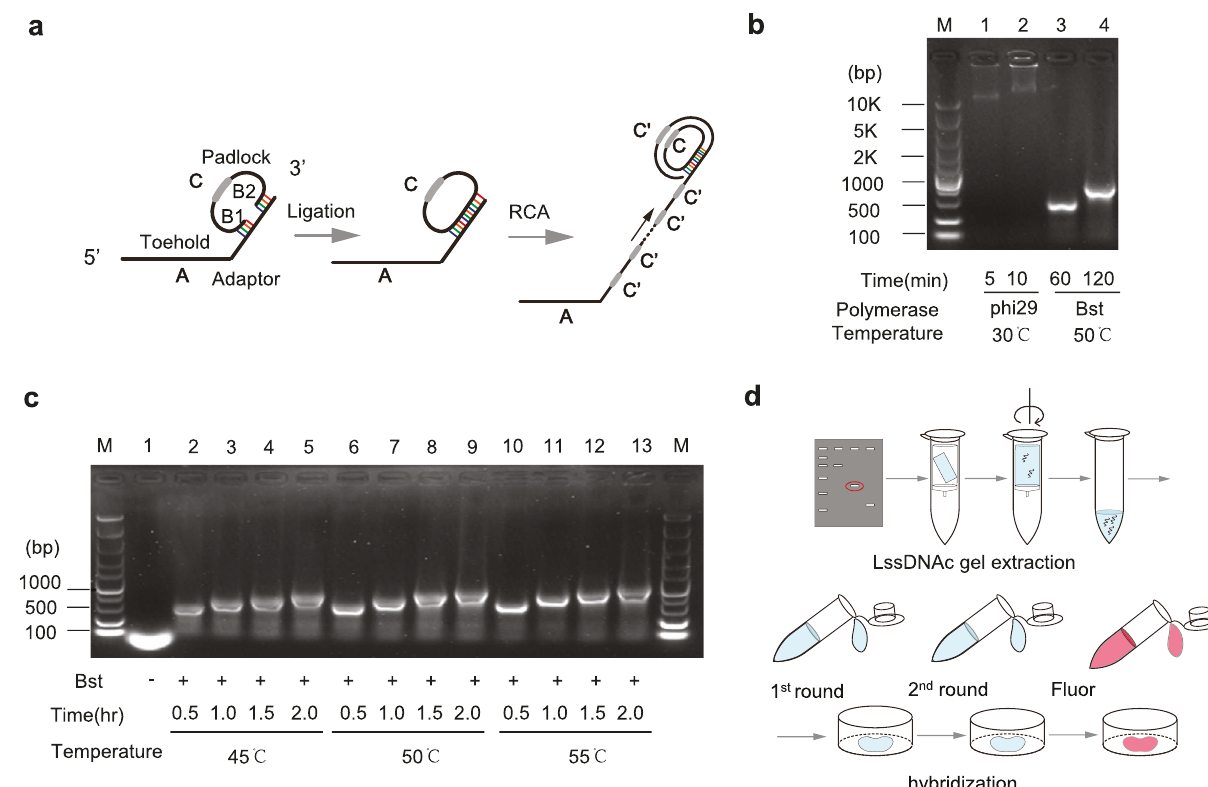
Fig. 1 Preparation of lssDNAc. a Schematic representation of the extension reaction for lssDNAc. Both nucleotides of 5 ʹ and 3 ʹ termini of the padlock can complementarily bind to the 3 ʹ termini of the adaptor. Next, the padlock is ligated at 5 ʹ and 3 ʹ termini by DNA ligase to form a closed circle. The adaptor ssDNA can be extended using the closed padlock as a template using RCA. b The ampli fi cation products were assayed via agarose gel electrophoresis. The extended products of adaptor ssDNA were ampli fi ed by phi29 DNA polymerase (lane 1 for 5 min, lane 2 for 10 min) and Bst 2.0 DNA polymerase (lane 3 for 1 h, lane 4 for 2 h). c The ssDNA adaptors were ampli fi ed to form products of different lengths by Bst 2.0 DNA polymerase (lanes 2 – 14) under three reaction temperatures (45 °C for lanes 2 – 5, 50 °C for lanes 6 – 9, and 55 °C for lanes 10 – 13) with different ampli fi cation times (0.5, 1, 1.5, and 2 h), and in the absence of DNA polymerase (lane 1). d The schematic diagram depicting the preparation for lssDNAc and hybridization work fl